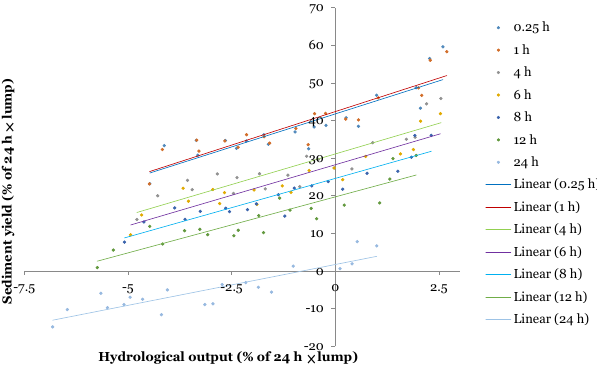
Figure 10. The relationship between hydrological output and sed- iment yield from each temporal resolution, based on outputs of the 20 jumble ensembles of the Upper Swale